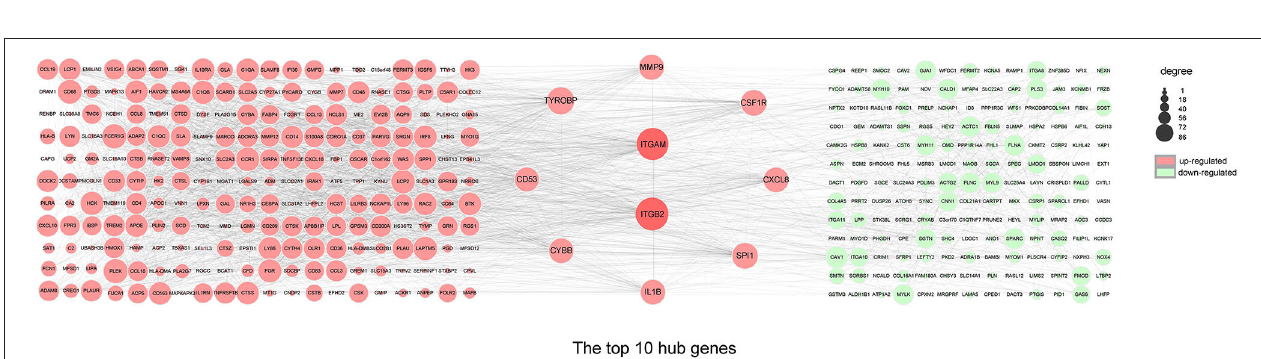
FIGURE 4 | Biofunctional enrichment analysis of DEGs. (A) GO functional enrichment analyses of DEGs and the top 10 BP, CC, and MF terms (BP, Biological Process; CC, Cellular Component; MF, Molecular Function). (B) KEGG pathway enrichment analyses of DEGs.